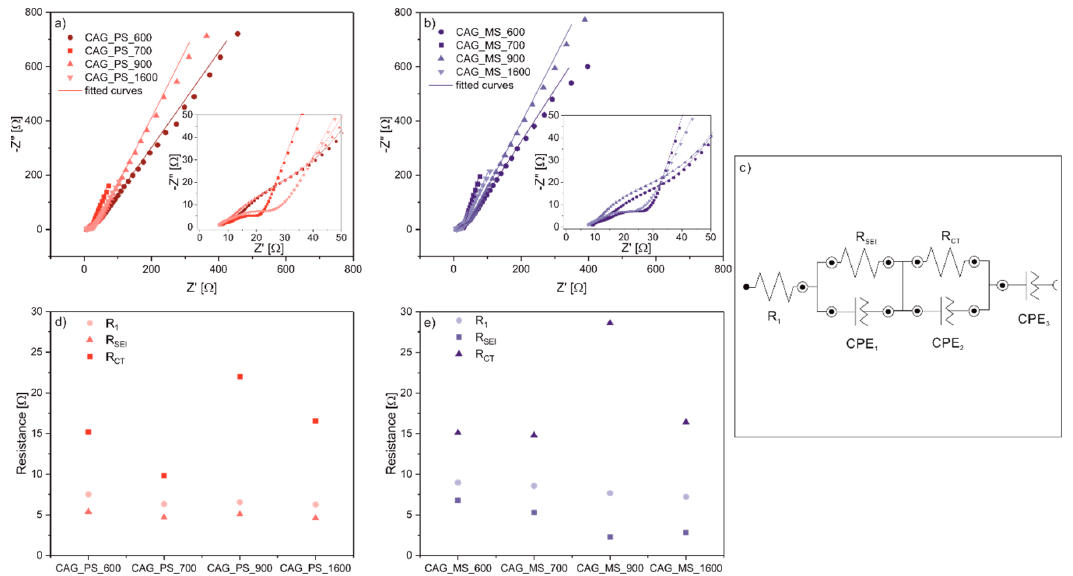
Figure 5. Nyquist plots for ( a ) Li/Li + /CAG_PS and ( b ) Li/Li + /CAG_MS cells with (c) the modeled ( d ) CAG_PS and ( e ) CAG_RS anode materials in Li-ion cell and their pyrolysis